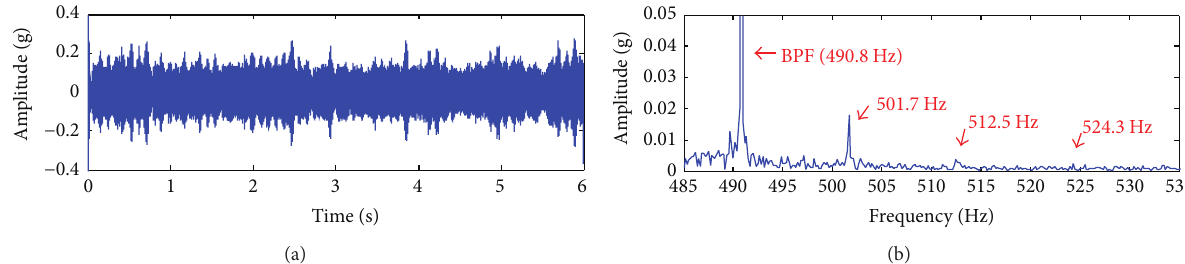
Figure 14: Output signals of the ASR method under 32 mm crack condition: (a) time-domain waveform and (b) frequency spectrum.